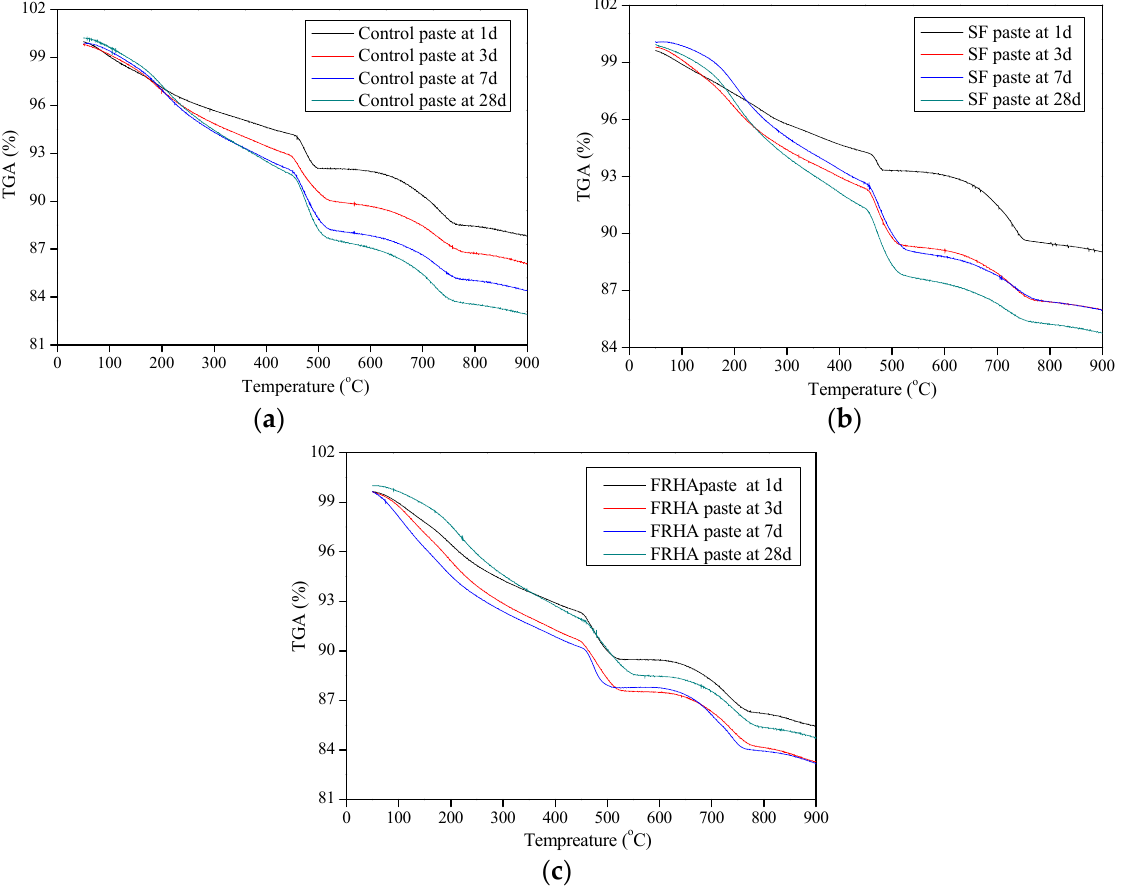
Figure 4. ( a ) TGA curve of control paste at 1, 3, 7, and 28 days; ( b ) TGA curve of SF paste at 1, 3, 7, and 28 days; and ( c ) TGA curve of FRHA paste at 1, 3, 7, and 28 days.